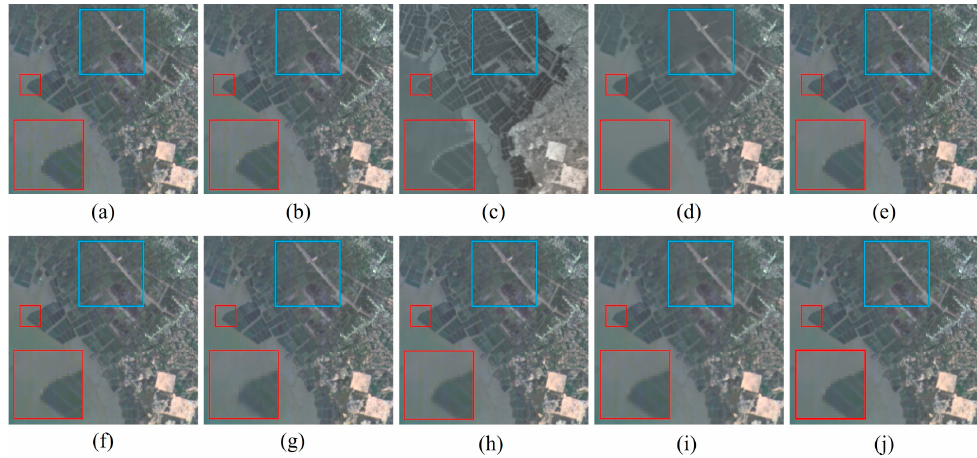
Figure 14. False color images synthesized with band 1, 34 and 61 of the denoised GF-5 data. ( a ) Original; ( b ) LRMR; ( c ) NAILRMA; ( d ) NGmeet; ( e ) L1HyMixDe; ( f ) E3DTV; ( g ) LRTDTV; ( h ) HSI-DeNet; ( i ) HSID-CNN; ( j ) ours.